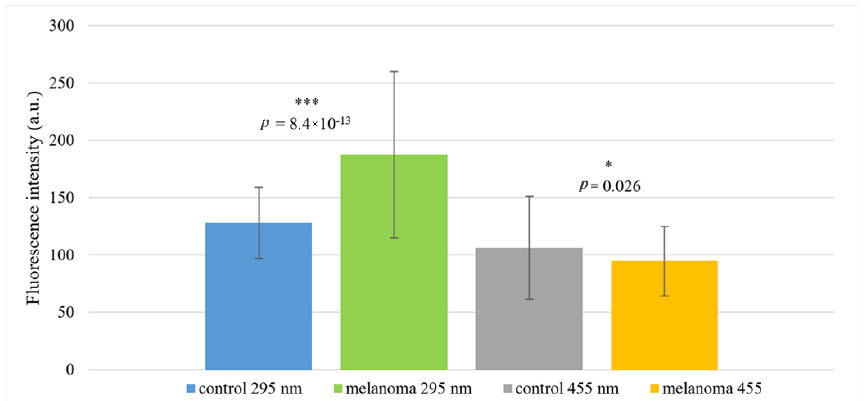
Figure 1. Average fluorescence profiles of urine in the control group and whole malignant mela- noma group. Rectangles indicate wavelength areas with significant differences; arrows indicate wavelengths with the largest statistical difference.